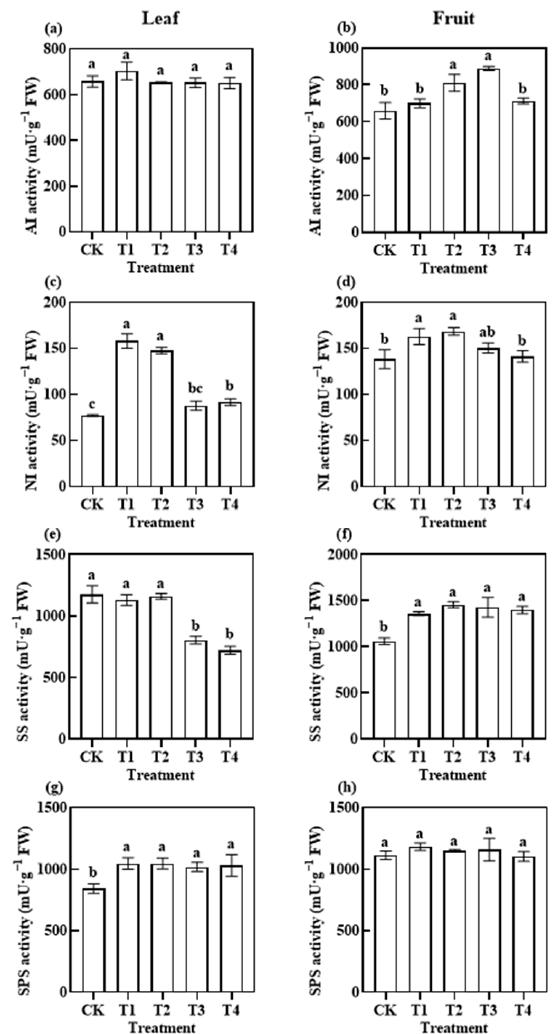
Figure 3. Effects of reduced fertiliser application before harvesting on the activities of C metabolism- related enzymes in plants. At the peak fruiting stage (the day of the fourth fruit harvest), samples were taken to determine the activities of C metabolism-related enzymes in leaves and fruits. AI ( a , b ) acid sucrose invertase; NI ( c , d ) neutral sucrose invertase; SS ( e , f ); SPS ( g , h ) sucrose phosphate synthase: sucrose synthase. Data were the means of three replicates with standard error ( ± SE). Different letters indicated significant differences between treatments at p of 0.05 according to Tukey’s multiple range test (n = 3). With no fertiliser reduction as the control (CK), the T1, T2, T3 and T4 treatments represented 20%, 40%, 60% and 80% reduction in fertiliser application from 0 to 6 days before each harvest, respectively.